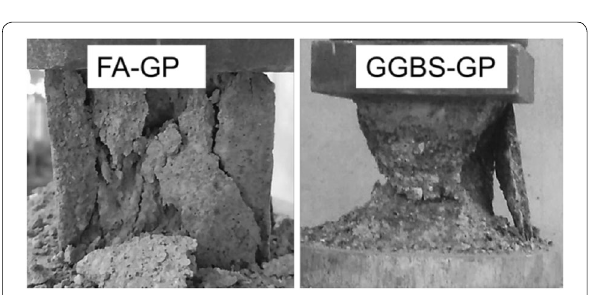
Fig. 7 Failure pattern of geopolymer mortar